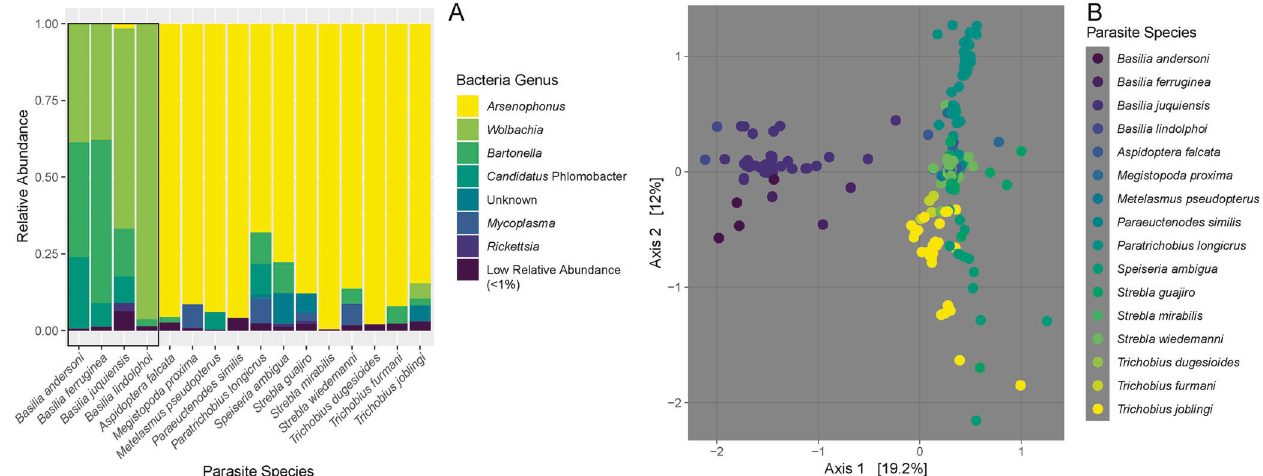
Fig. 2 Bat fl y microbiome composition. Relative abundance of each bacterial genus summed across repeated samples of each parasite species ( A ). Colors indicate different bacterial genera and bars represent each parasite species. The black box surrounds the nycteribiid bat fl ies. Low abundance bacteria were those comprising less than 1% relative abundance in each species. Unknown bacteria could not be identi fi ed to genus using the GreenGenes database. Principal Coordinates Analysis on the Euclidean distances between philr-transformed microbial abundances of the complete dataset ( B ). Colors represent parasite